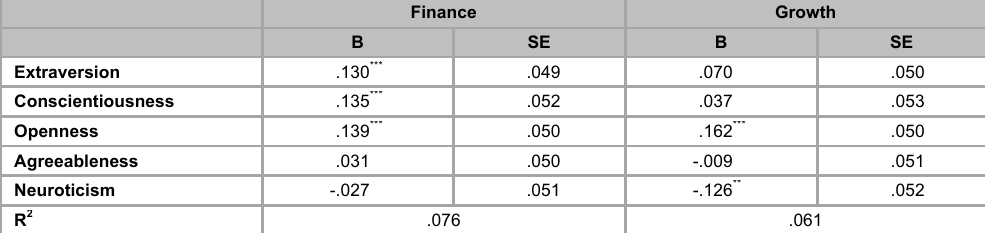
Farrington’s regressions with common method bias latent